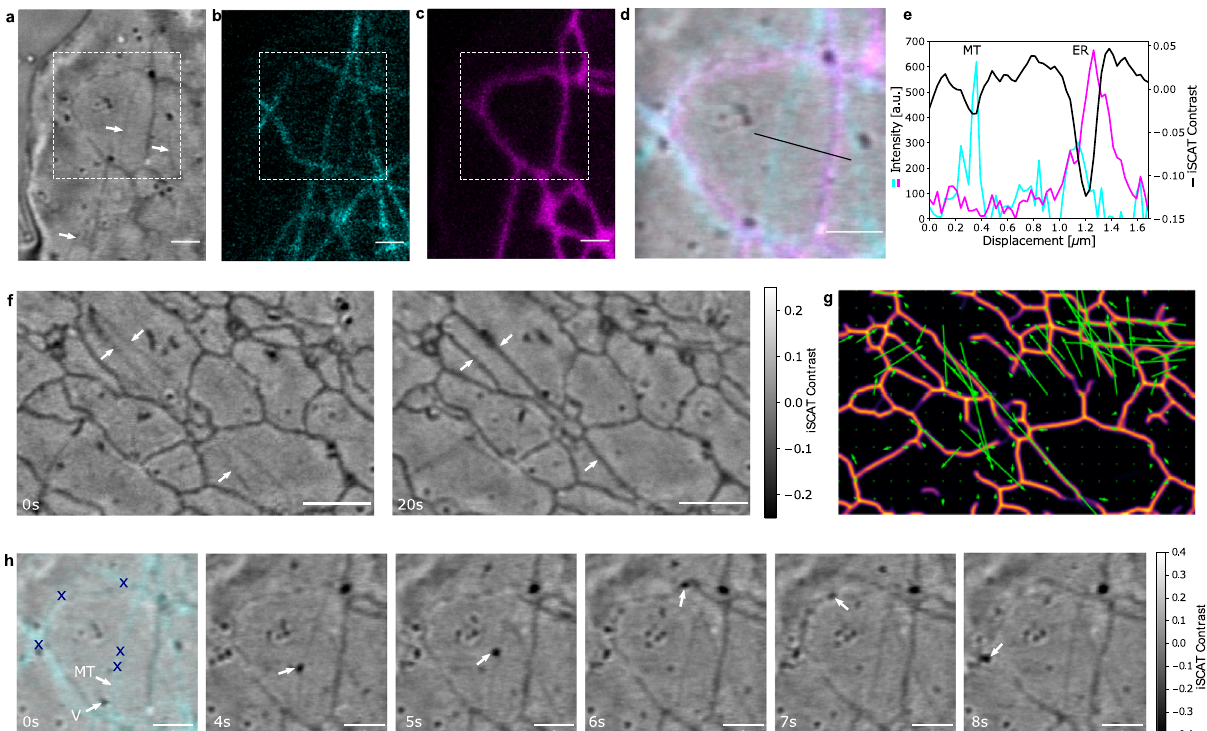
Fig. 4 | Ultrahigh sensitivity in imaging microtubules in live cells. a Exemplary raw C-iSCAT image of the periphery of a COS-7 cell showing vesicles, ER network and MT. Corresponding CF images of MTs labeled with mEGFP-tubulin ( b ) and ER tubuleslabeledwithCytERM-mScarlet( c ).Scalebarsare1 μ m. d Overlayof a – c fora regionmarkedin a .Scalebaris1 μ m. e Acrosssectionalongthecutin d ,displaying the C-iSCAT (black) and fl uorescence signals of MT (cyan) and ER (magenta). The focal plane was adjusted to be able to extract the maximum negative contrast of both MTs and ER tubules. f Exemplary raw C-iSCAT image from the periphery of a